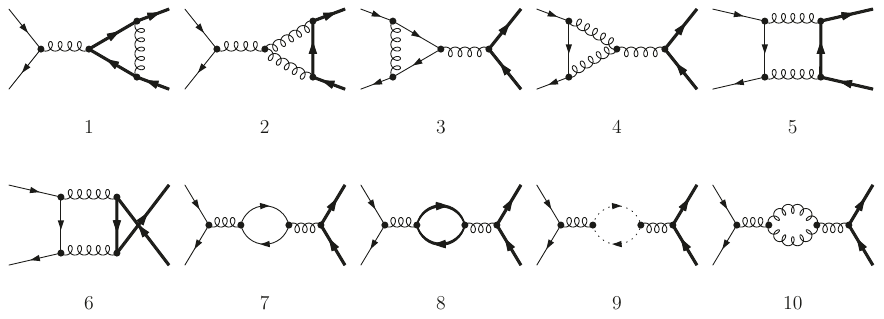
¯ Q . Thin lines indicate a light quark